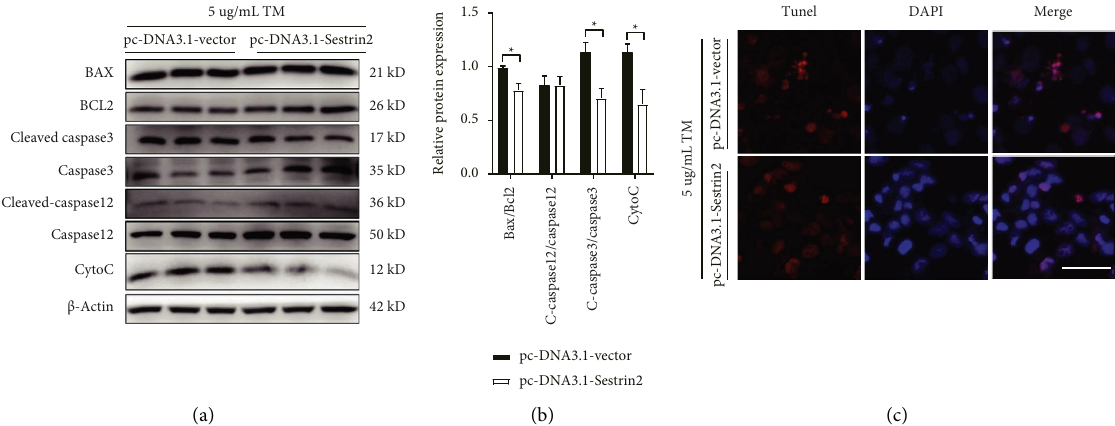
Figure 3: Sestrin2 overexpression ameliorates TM-induced HepG2 cells apoptosis. (a) Representative western-blot results of proteins involved with cell apoptosis (b) Quantitative analysis of proteins involved with cell apoptosis (unpaired two-tailed t -test; for Bax/Bcl2: t (4) � 3.03, P � 0 . 039; for C-caspase3/caspase3: t (4) � 3.33, P � 0 . 029; for CytoC: t (4) � 3.19, P � 0 . 033). (c) Representative images of TUNEL positive HepG2 cells in indicated groups. Scale bar, 50 μ m. ∗ P < 0 .